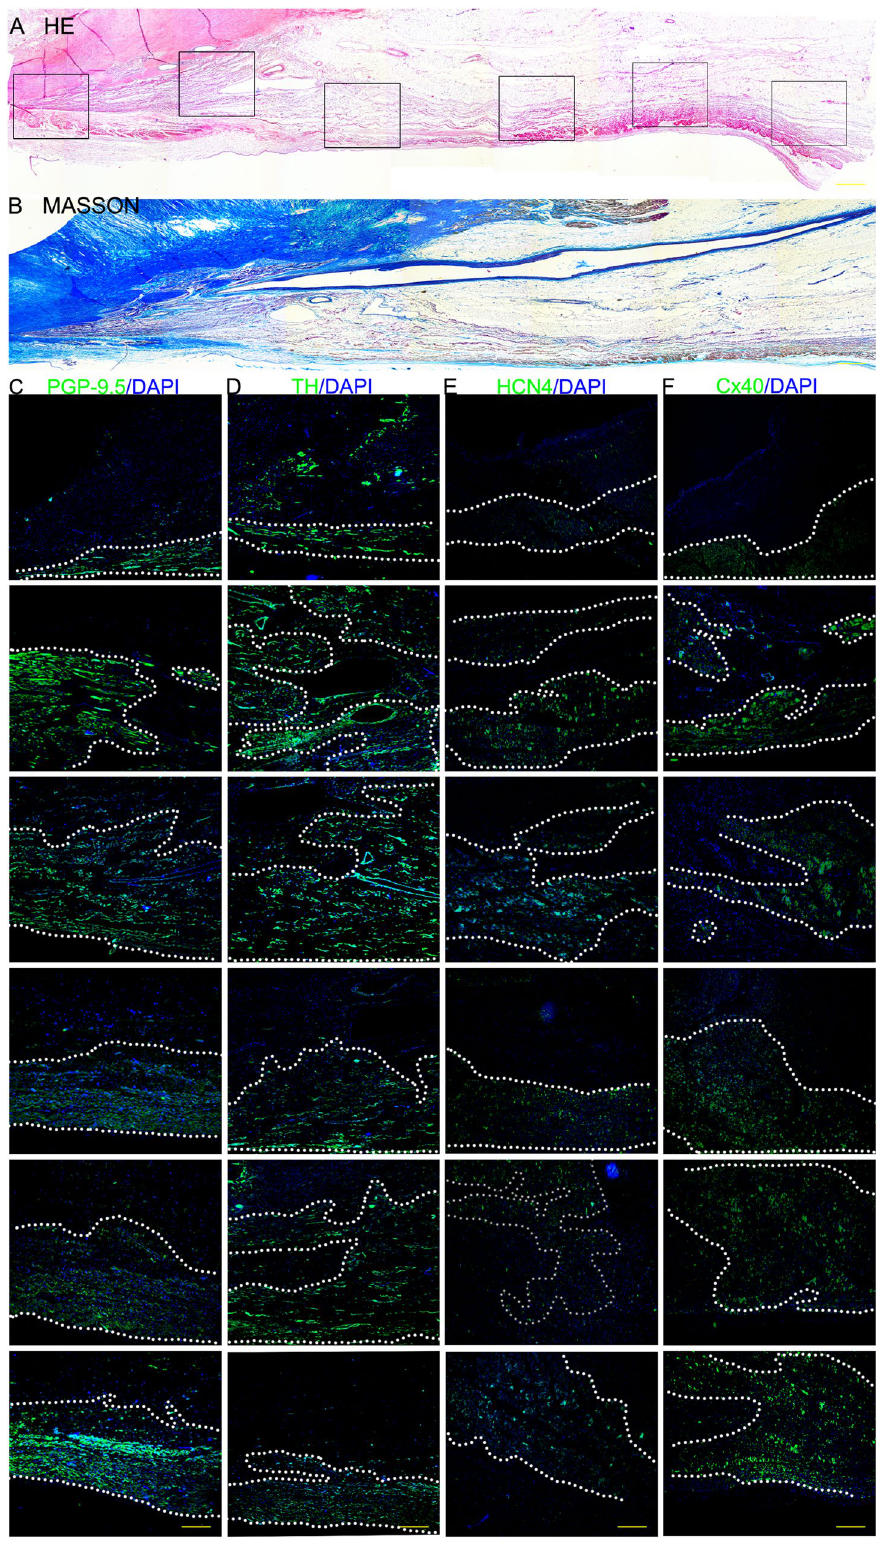
Figure 2. The results of the histological and immunofluorescence examination of the AVN. ( A ) HE staining (scale bar = 1200 μ m). ( B ) Masson staining (scale bar = 1200 μ m). ( C ) Immunofluorescence staining with the anti-PGP9.5 antibody. ( D ) Immunofluorescence staining with the anti-TH antibody. ( E ) Immunofluorescence staining with the anti-Cx40 antibody. ( F ) Immunofluorescence staining with the anti-HCN4 antibody. In C–F , the green region is the positive area, and the cell nuclei are stained with DAPI, scale bar = 400 μ